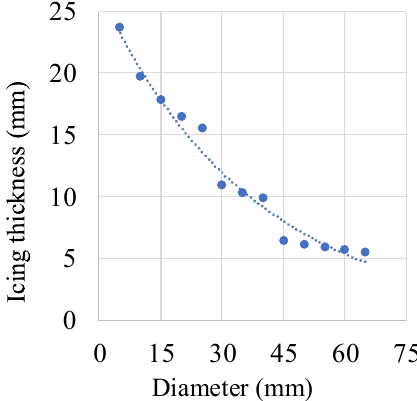
Figure 14. Relationship between ice thickness and conductor diameter.